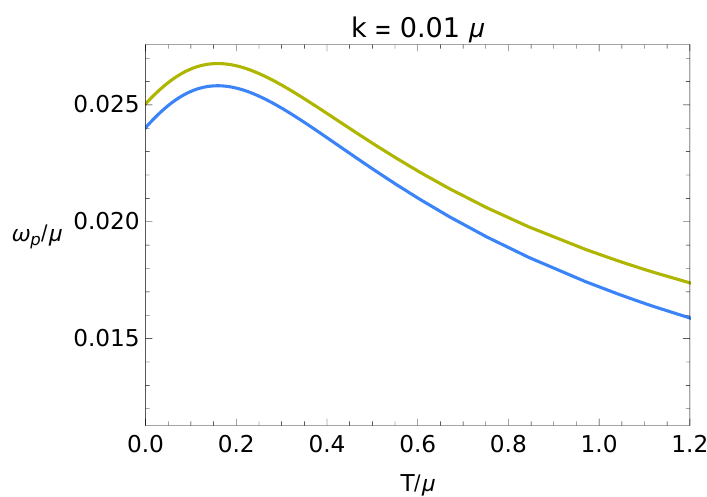
Figure 9. Temperature dependence of the hydrodynamic plasma frequency for j k j =(cid:22) = 0 : 01 and (cid:11) 2 = 2 = 1 = 10, with (green) and without (blue) a higher-order momentum correction v 2 that the plasma frequency has a maximum at T=(cid:22) = 1 = 2 (cid:25) , corresponding to ! p ’ 0 : 0268 (cid:22)